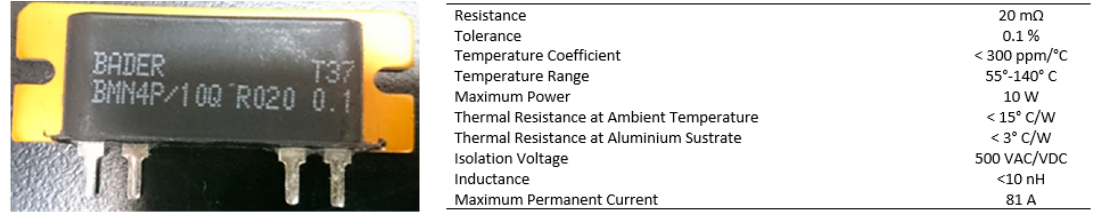
Figure 8. Shunt resistance used in the assays; shunt resistance datasheet.